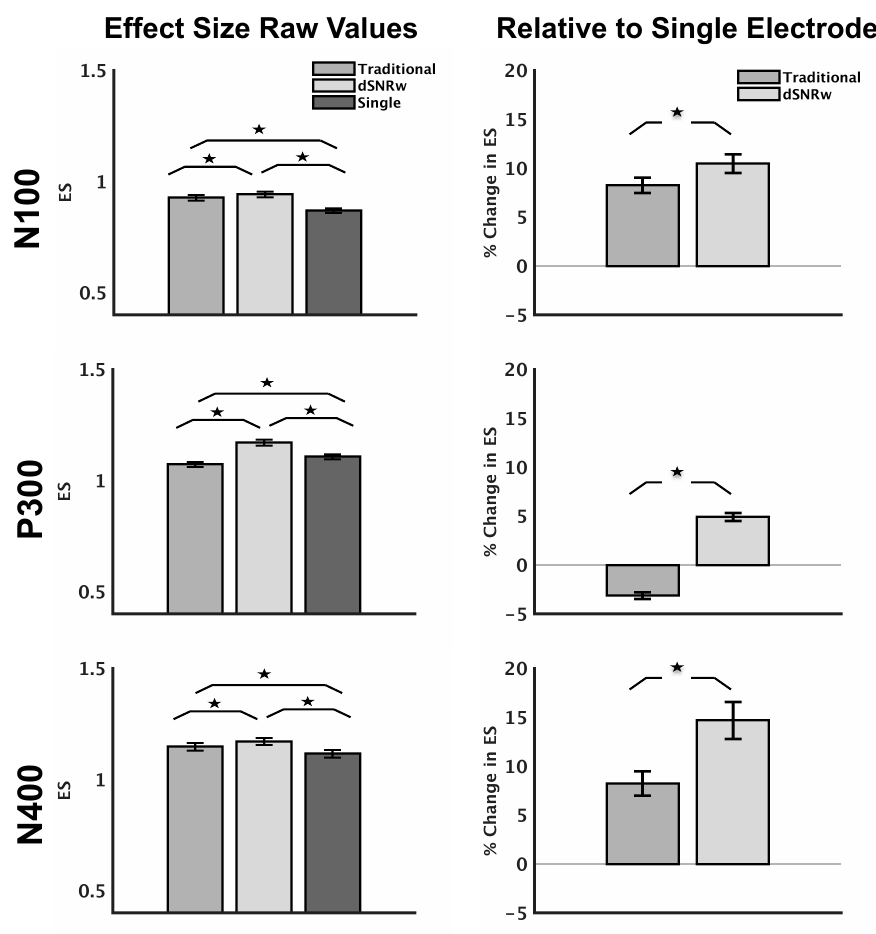
Figure 4. Effect size measurements for experimental N100, P300 and N400 ERPs, presented mean ± SEM. ( Left ): ES measurements for all three ERPs are shown at midline electrodes. ( Right ): The relative percentage change in ES for each of the two combinatorial approaches relative to the single electrode with the largest ES. * p < 0.001. Traditional, dSNRw = channel pooling techniques; Single = electrode with the largest effect size measurement.